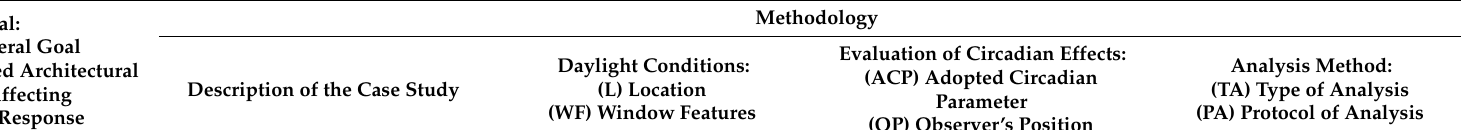
Table 2. Papers analyzing factors related to technological and interior design focusing on